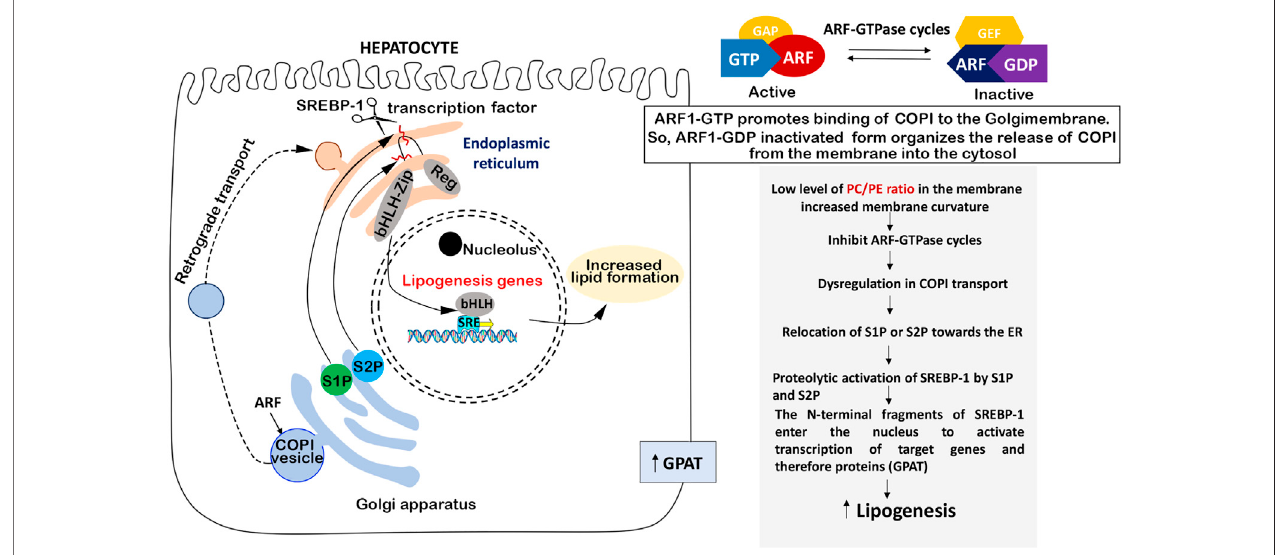
FIGURE 3 | PCH-dependent SREBP regulation . PCH enrichment in membranes decreases the membrane curvature which leads to ARF-GTFase cycle activation and COPI transport repair without excess relocation of S1P and S2P proteinase from Golgi to the ER. This means inhibition of SREBP-1 and, therefore, SREBP-1- dependent lipogenic